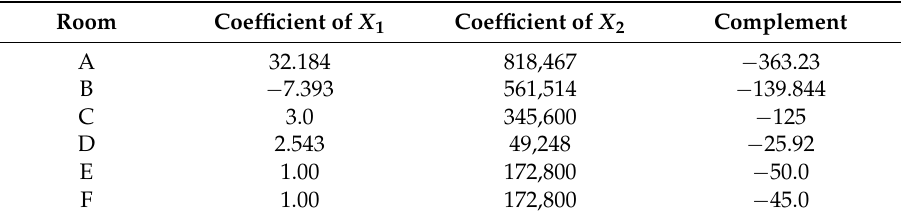
Table 6. List of the coefficients.